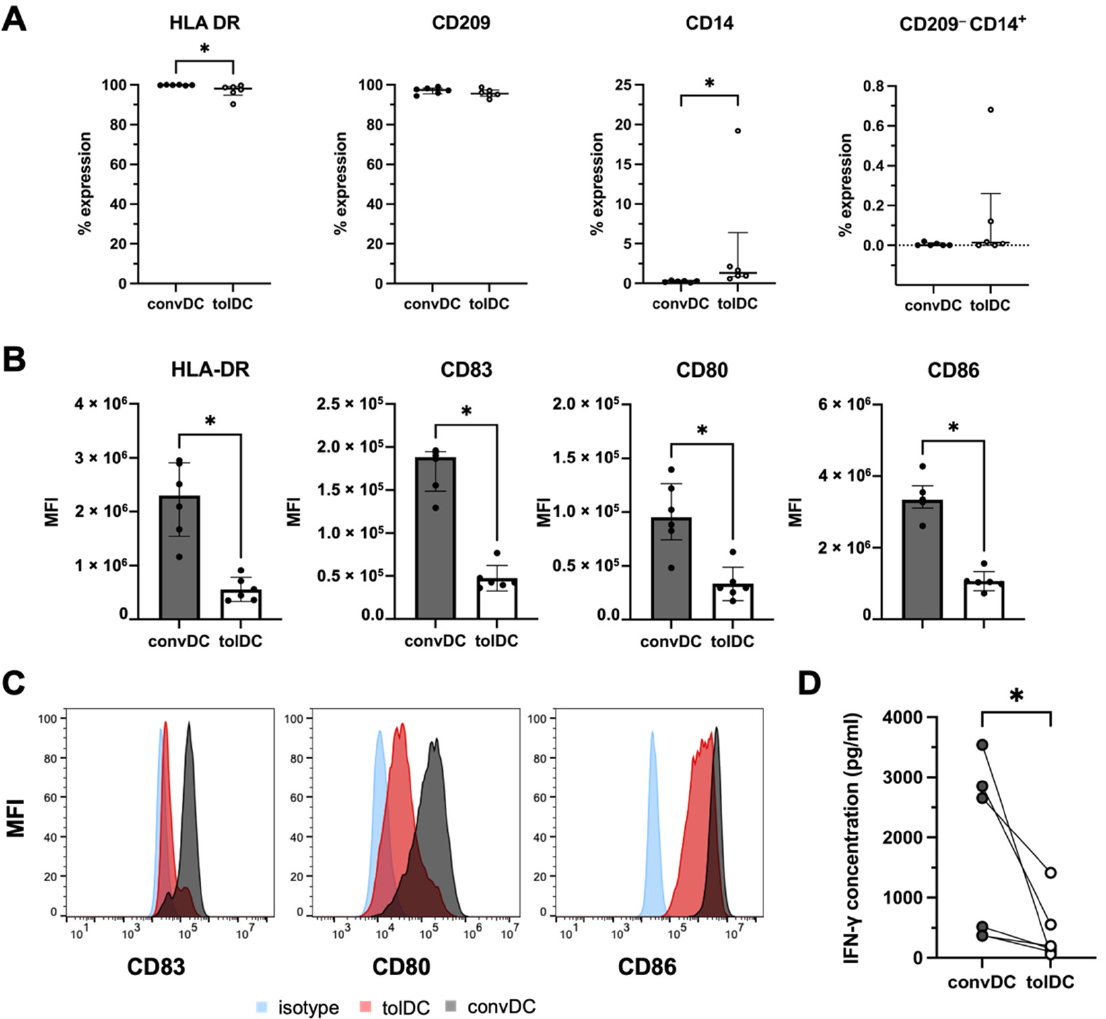
Figure 1. TolDC display a semimature phenotype and reduced T cell stimulatory capacity. ( A ) The percentage of cells expressing the markers HLA-DR, CD209 and CD14 and the percentage of cells that are CD209 neg CD14 pos . TolDC are indicated in white dots; convDC are indicated in black dots (n = 6). ( B ) Expression levels of HLA-DR, CD83, CD80 and CD86 shown as MFI values of tolDC (white bars) or convDC (black bars) (n = 6). ( C ) Representative histogram overlay of CD83, CD80 and CD86 expression levels by tolDC (red), convDC (black) and isotype control (blue). ( D ) Concentration in pg/mL of IFN- γ secretion by PBL stimulated with convDC (black dots) and tolDC (white dots) (n = 6). Significance ( p < 0.05) is indicated by *.